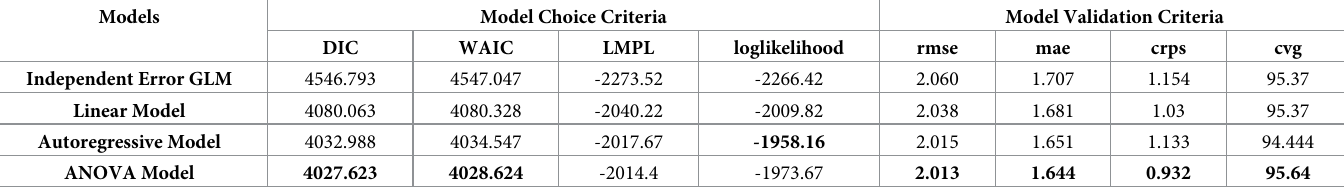
Table 2. Performance measures of the selected models.